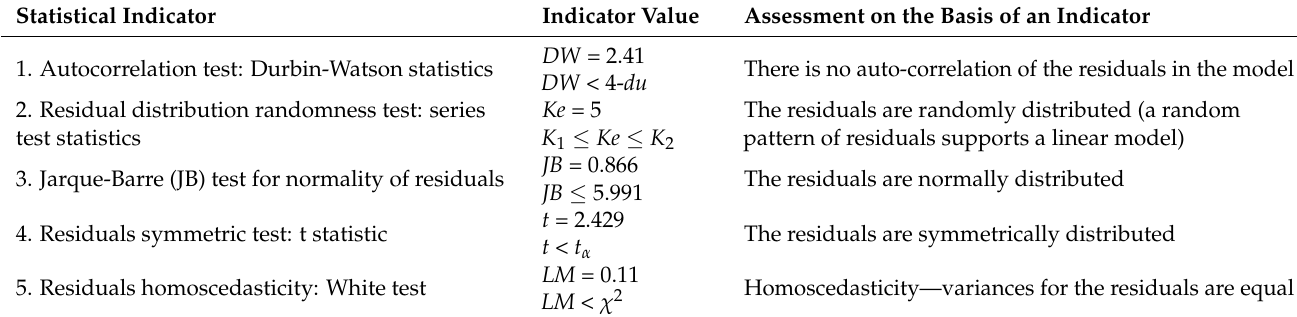
Table 2. Statistical verification of the model no. 1 by using statistical